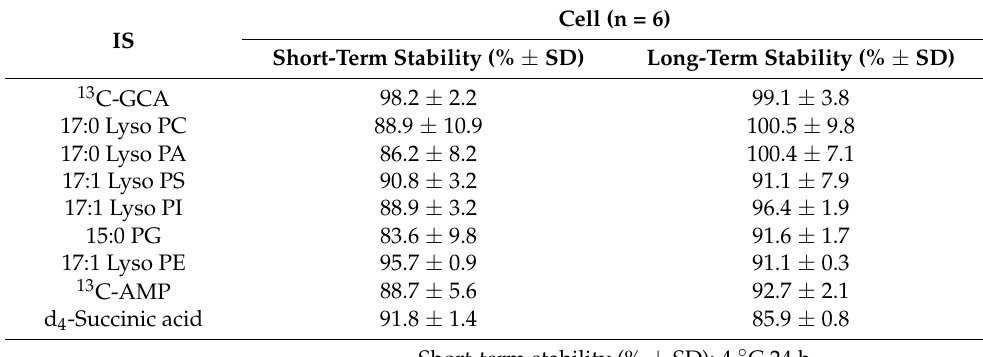
Table 3. Stability data of the target